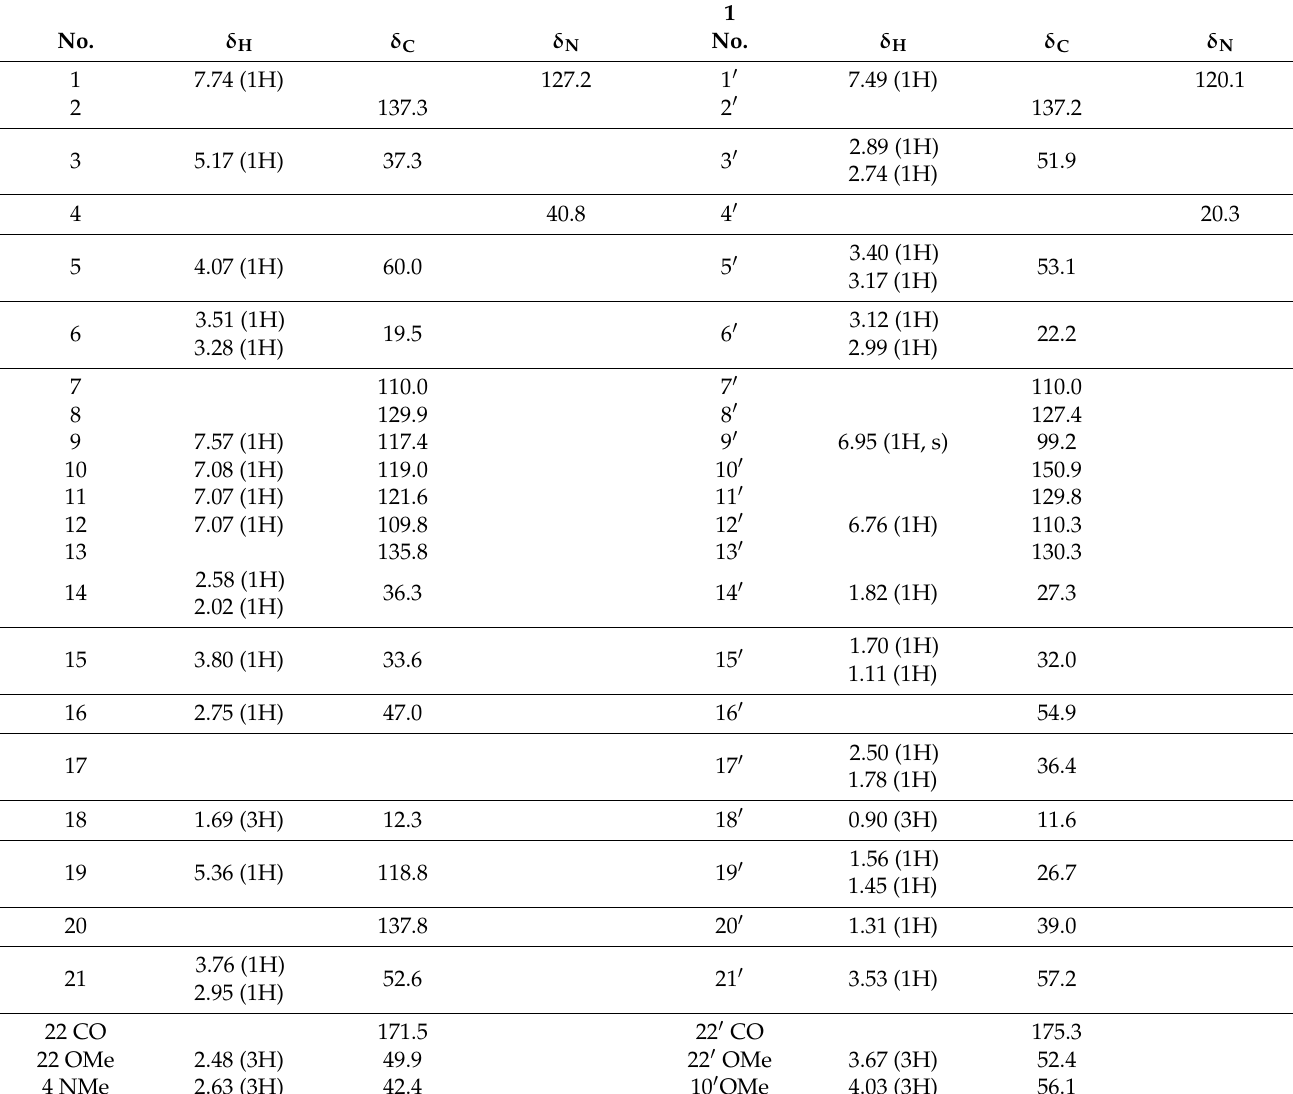
Table 1. 1 H (500 MHz) and 13 C-NMR (125 MHz) assignments for compound 1 in CDCl